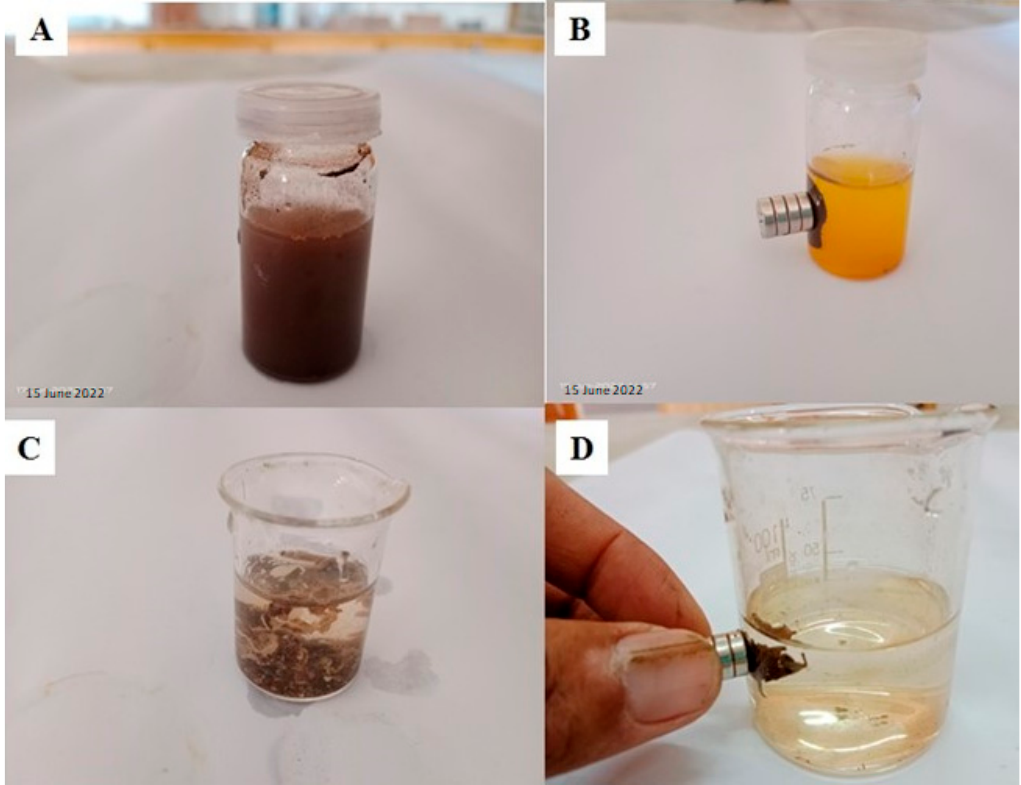
Figure 2. Magnetic behavior of the synthesized magnetic nanoparticles ( A , B ) and MCM-PA@B ( C , D